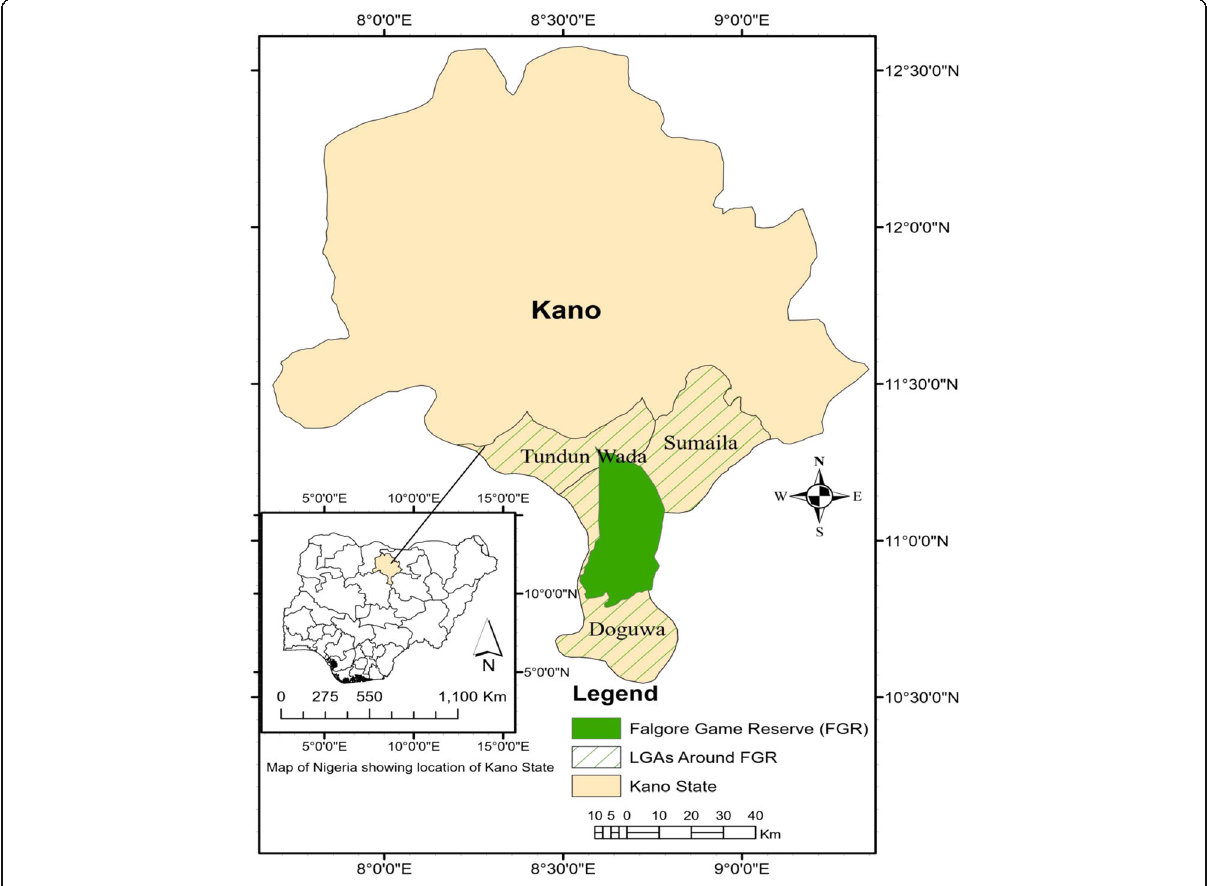
Fig. 1 Map of Kano, Nigeria indicating selected area for this